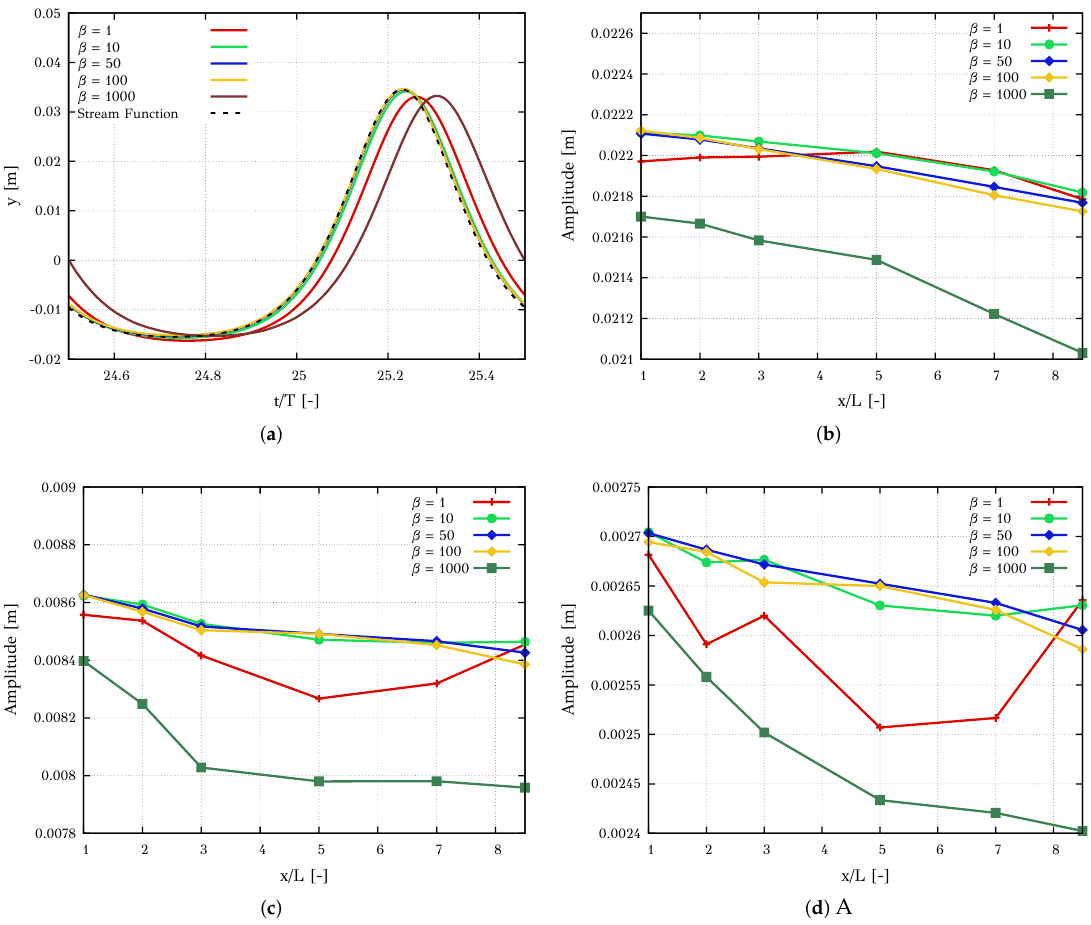
Figure 6. Influence of the AC β parameter: Wave characteristics: T = 5 s, H = 0.05 m, d = 0.5 m, λ = 11.08 m. ( a ) Wave elevation 5 wave lengths after the wave generation zone. The snapshot is after 25 wave periods; ( b ) Amplitude of the 1st harmonic of the wave at various grid locations; ( c ) Amplitude of the 2nd harmonic of the wave at various grid locations; ( d ) mplitude of the 3rd harmonic of the wave at various grid